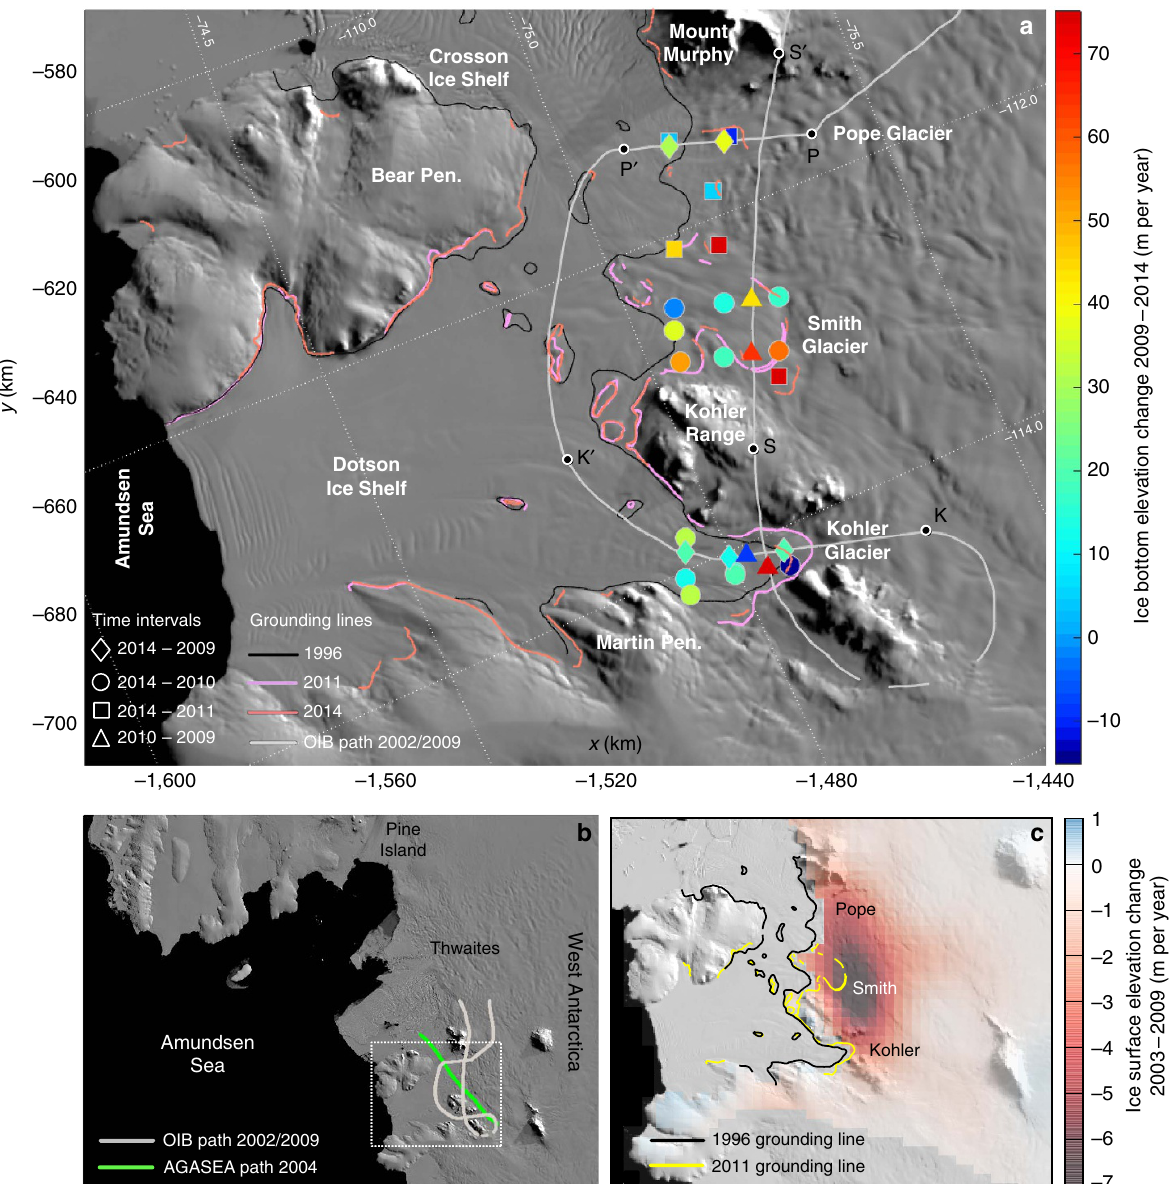
Figure 1 | The study area of the Dotson and Crosson ice shelves and their tributary glaciers. ( a ) The repeat flight path of the 2002 and 2009 Operation IceBridge (OIB) campaigns, with the letters S-S 0 , P-P 0 and K-K 0 marking the endpoints of the profiles in Figs 2–4. Colour scale shows bottom ice elevation changes at crossover locations of non-repeating OIB tracks between the years 2009 and 2014. At each crossover location, the bottom elevation of the earlier year is subtracted from that of the latter, hence positive values indicate bottom ice loss. The differences found are then averaged over the length of the time interval to facilitate comparisons. Uncertainty varies between B 35m per year for the 1-year interval to B 7m per year for the 5-year interval (Methods). Grounding lines are from refs 13 and 19, and background image is from the 2008–2009 MODIS Mosaic of Antarctica 50 (MOA). ( b ) The study area of Fig. 1a located on a map of the ASE region by the white rectangle showing the flight paths analysed here of the 2002 and 2009 OIB campaigns, and the 2004 AGASEA campaign along the Smith-Kohler glacier trunk. ( c ) Surface lowering rates for the period 2003–2009 adapted from ref. 1. The authors used ICESat-1 measurements with the necessary corrections, with ATM and other data products applied as additional constraints to the surface shape and elevation time